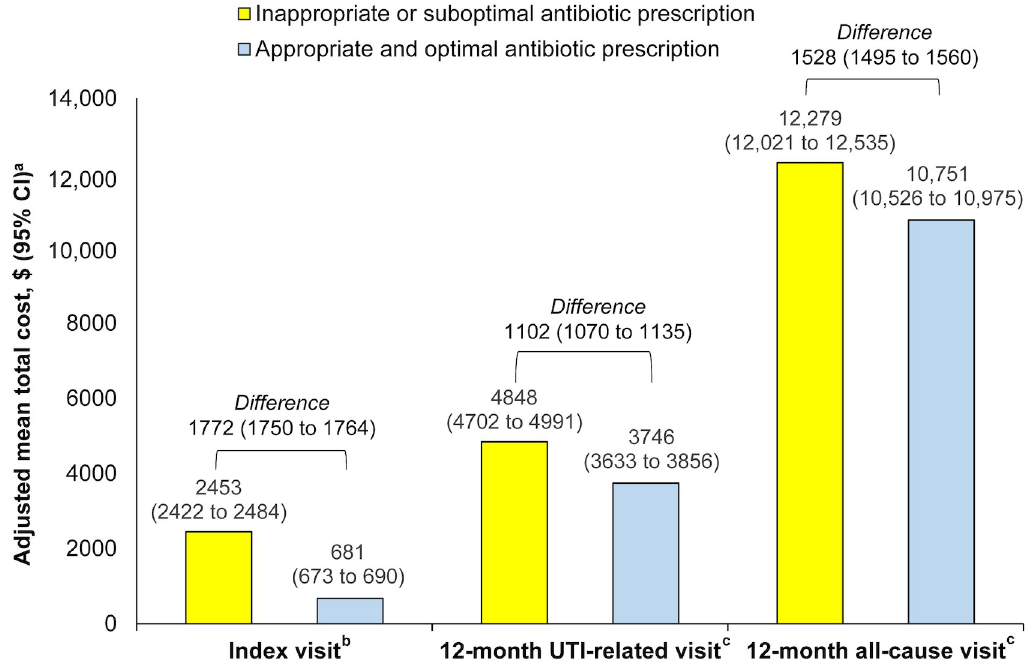
Fig 1. Total 12-month UTI-related and all-cause visit costs (adjusted), stratified by appropriateness of antibiotic prescription at index and during follow-up. Abbreviations: CCI, Charlson Comorbidity Index; CI, confidence interval;